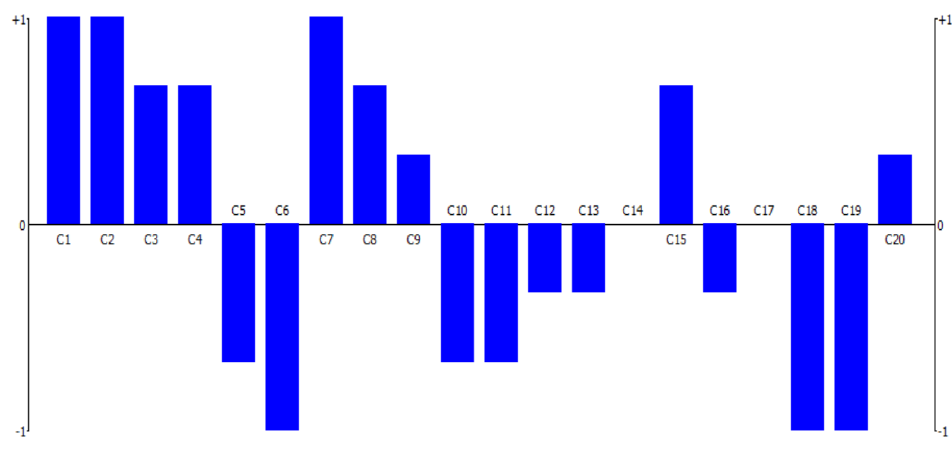
Buildings 2021 , 11 , 523 13 of 25